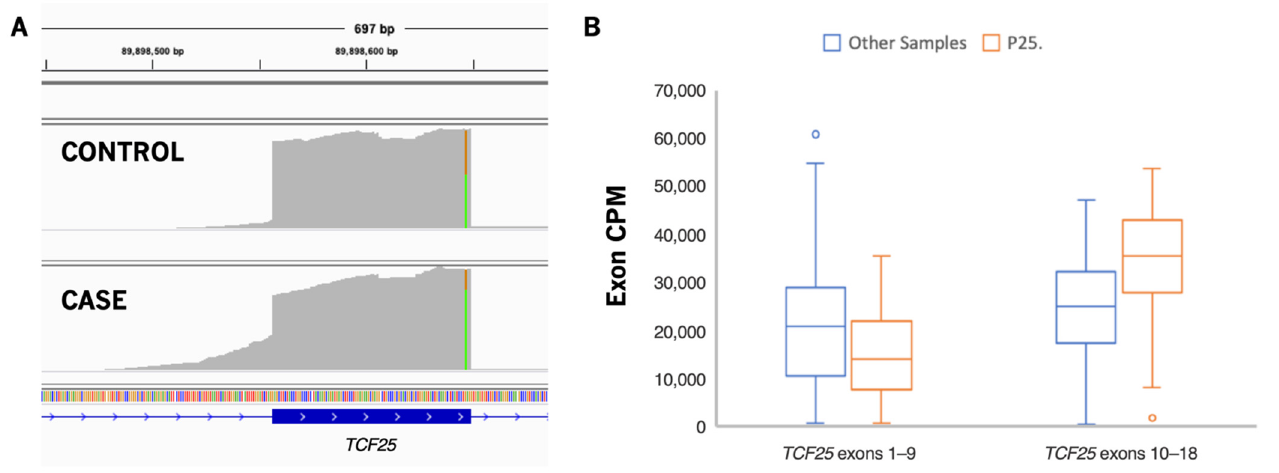
Figure 3. Possible aberrant event in TCF25 . ( A ) Exon 10 of TCF25 in an unaffected sample and in P25 showing evidence of intron retention and allele-specific expression. The variant seen in this exon is a common polymorphism, but shows unbalanced allele expression in P25. ( B ) Normalized exon usage in exons prior to the intron retention event compared to the affected exon and following exons.